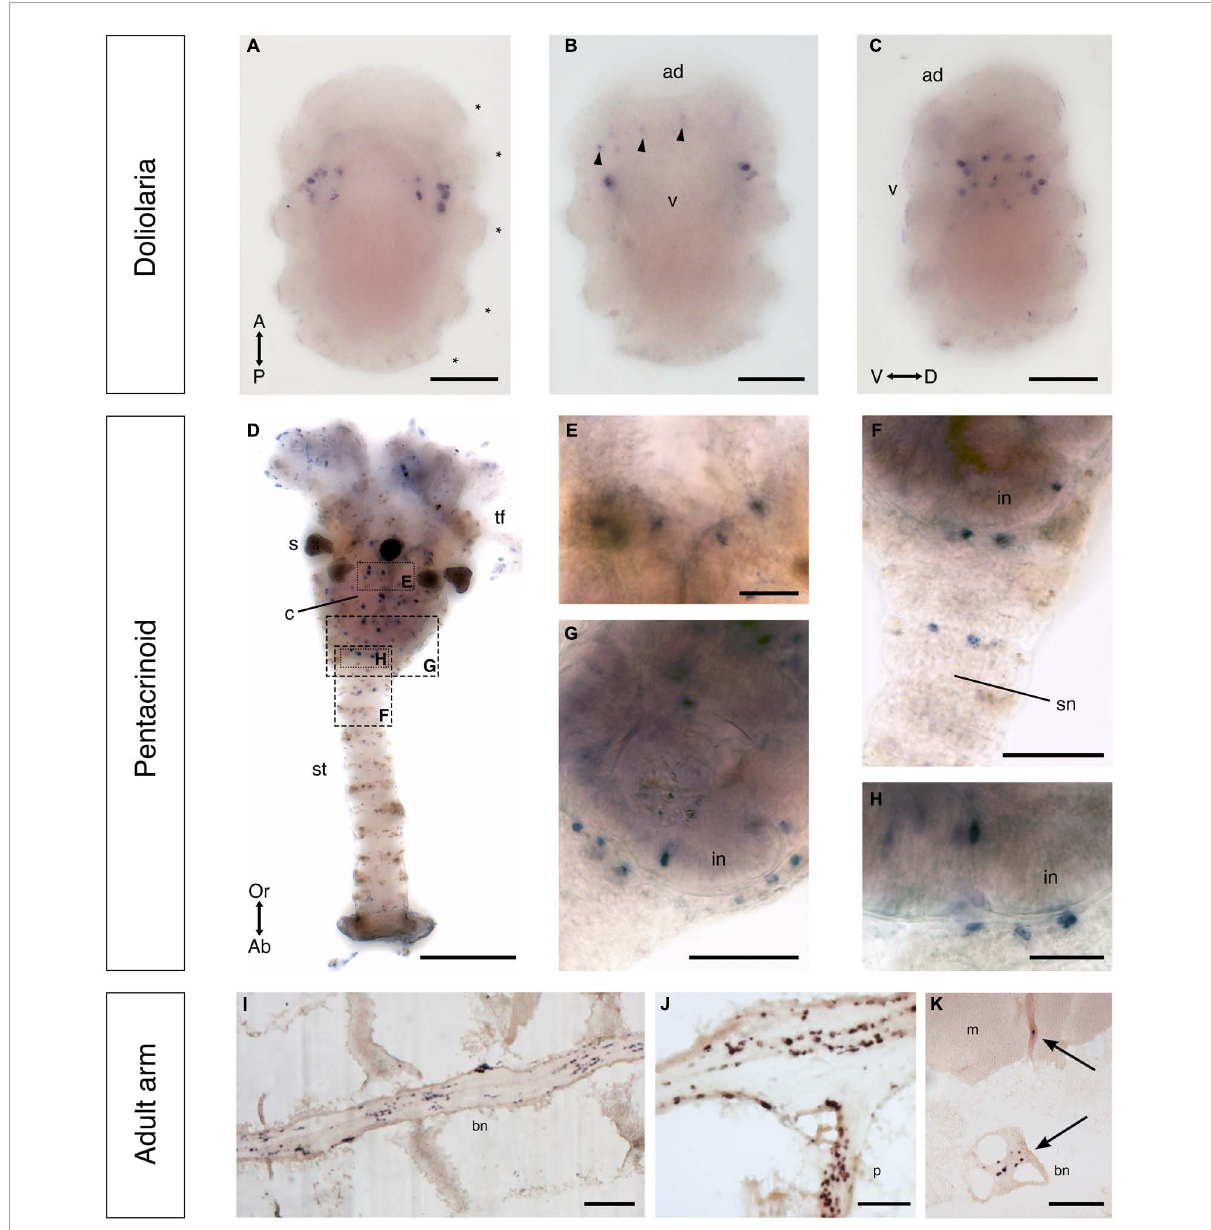
FIGURE11 F-type SALMFamide precursor expression across different life stages of Antedon mediterranea revealed using mRNA in situ hybridization. (A–C) Doliolaria larva from dorsal (A) , ventral (B) , and lateral (C) views, showing strong staining in two symmetric dorso-lateral clusters of cells located between the second and third ciliary bands (asterisks) and weak staining in sparsely distributed cells located in an anterior-ventral position (arrowheads in panel B ). (D–H) A pentacrinoid juvenile (D) , showing stained cells in both the calyx and stalk. High magnification images of the boxed regions in (D) show stained cells in mouth (E) , stalk nerve (F) and aboral nerve center (G,H) . (I–K) Longitudinal (I,J) and transverse (K) sections of arms from adult animals, revealing stained cells in the brachial nerve (I) , branches of the brachial nerve that project into the pinnules (J) and flexor muscles (K) . Scale bars: 150 µ m for (A–D,I) ; 75 µ m for (F,G,J,K) ; 25 µ m for (E,H) . A, anterior side; Ab, aboral side; ad, adhesive pit; bn, brachial nerve; c, calyx; D, dorsal side; m, muscle; in, intestine; Or, oral side; P, posterior side; p, pinnule; s, saccules, sn, stalk nerve; st, stalk; tf, tube feet; V, ventral side; v,